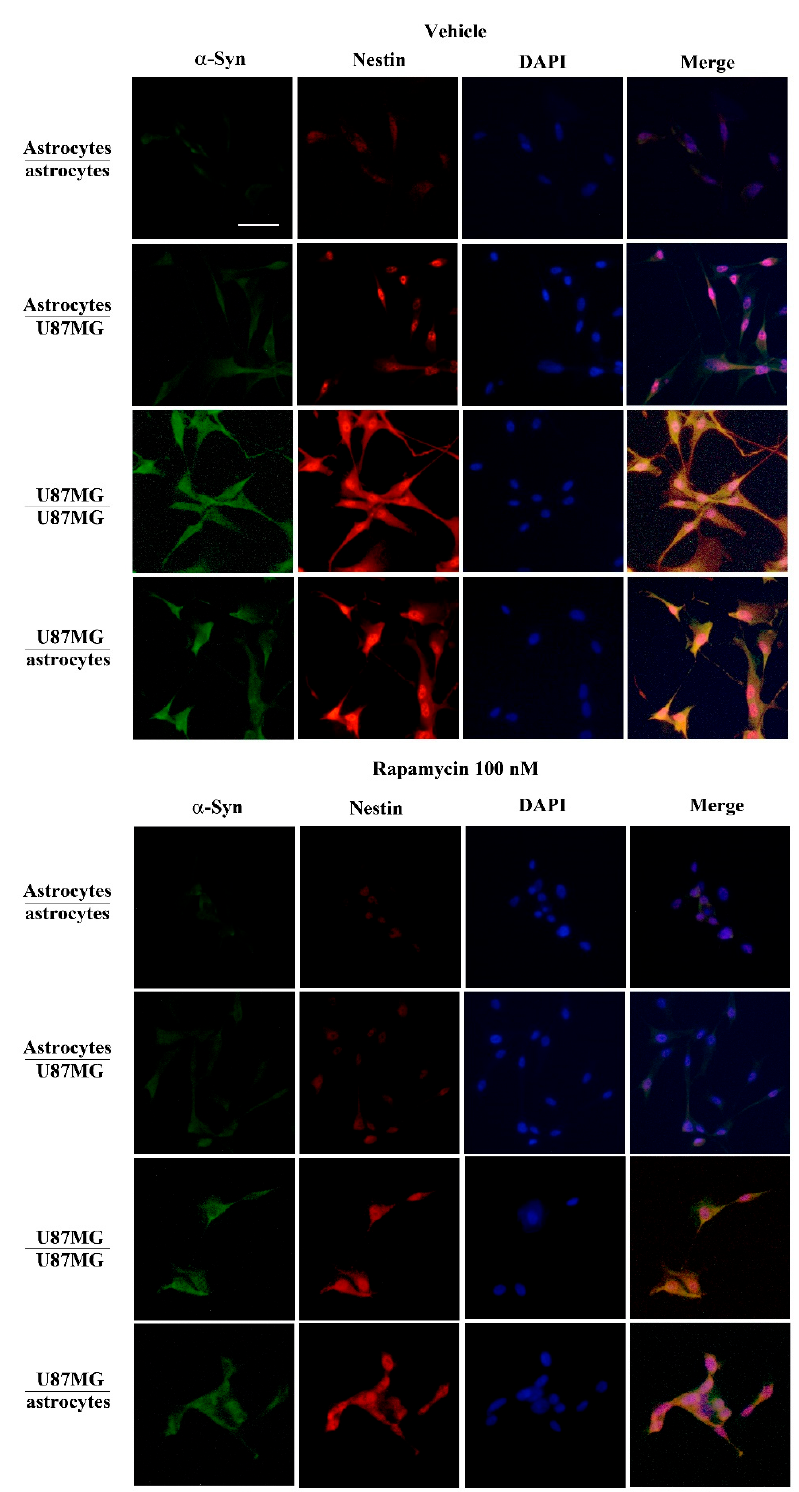
Figure 9. α -Syn parallels nestin expression in co-cultures of astrocytes and GBM cells with or without rapamycin (100 nM). Representative pictures show immuno-fluorescence for α -syn (green), nestin (red) and nucleus DAPI fluorescence (blue) and their merge (pink), within co-cultures of astrocytes and GBM cells in baseline conditions (vehicle) and following rapamycin administration (Rapamycin 100 nM). Scale bar = 28 μ m.